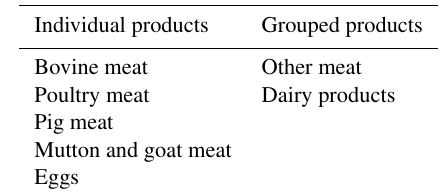
Table B2. Animal products and groups. In the case of these an- imal products, the “individual” animal products represent a small group of products but are dominated by a single product. For ex- ample, while bovine meat includes derivative products and buffalo, the majority of the bovine meat supply and consumption is formed of cattle meat. There are only two sets of grouped animal products: dairy and “other meat”. Dairy is a significant contributor to global food supply and demand, but meat products not listed individually are not. Dairy includes milk, butter, ghee, and cream. Products such as cheese and yoghurt are also included in the data for